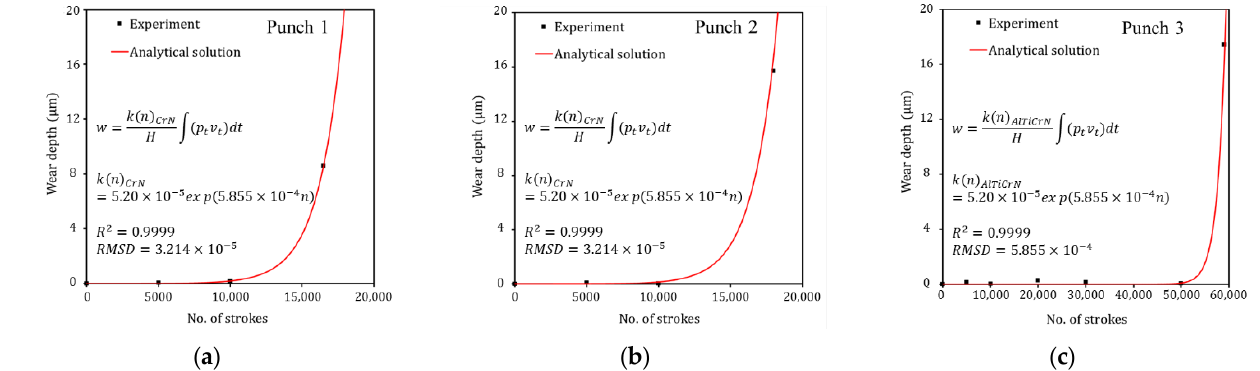
Figure 9. Definition of dimensionless wear coefficient k ( n ) of the analytical solution (Equation (4)) to accurately predict the evolutionary wear behavior of experimental wear data: ( a ) Punch 1 with a radius of 3.0 mm coated with PVD CrN, ( b ) Punch 2 with a radius of 5.5 mm coated with PVD CrN, and ( c ) Punch 3 with a radius of 3.0 mm coated with PVD